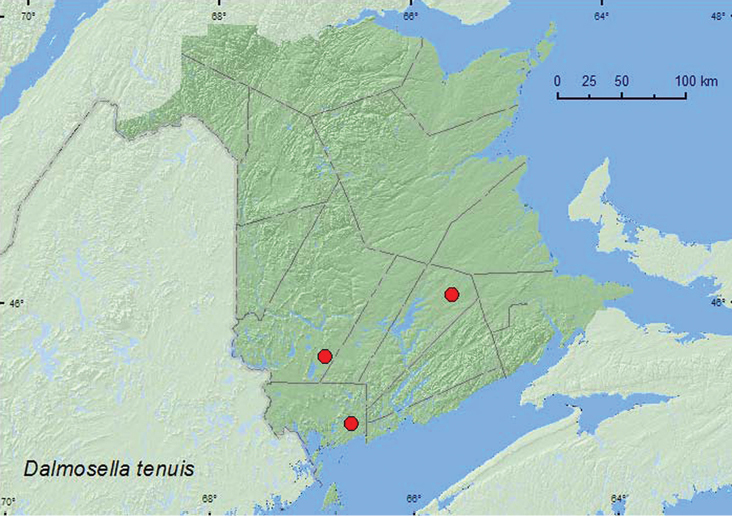
Collection localities in New Brunswick, Canada of Dalmosella tenuis.